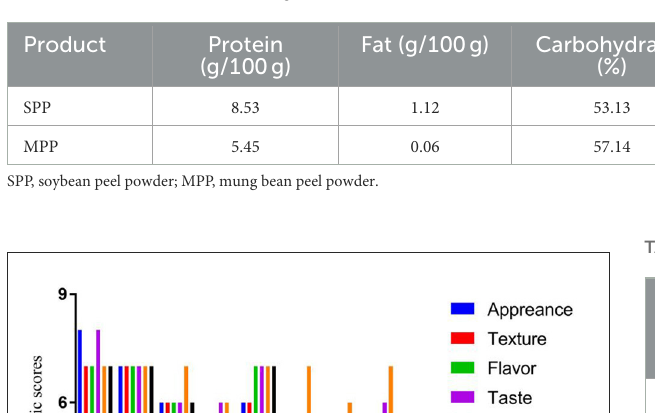
TABLE 4 Proximate chemical analysis.